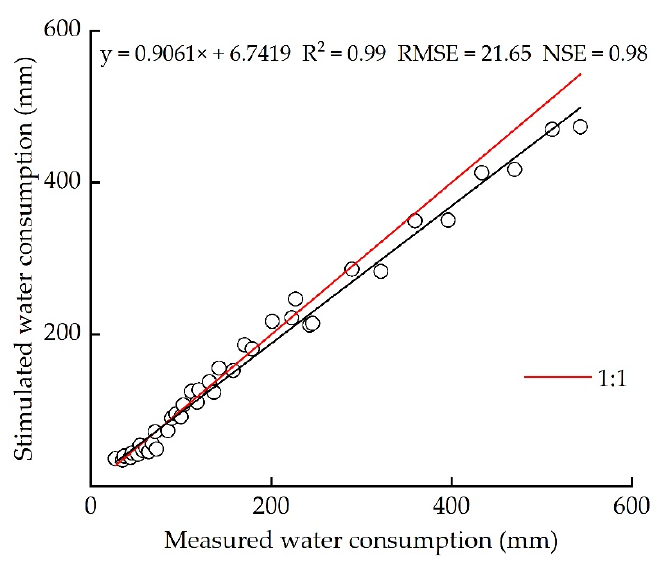
Figure 4. Comparison between measured and simulated values of water consumption during apple growing season in 2019 and 2020.